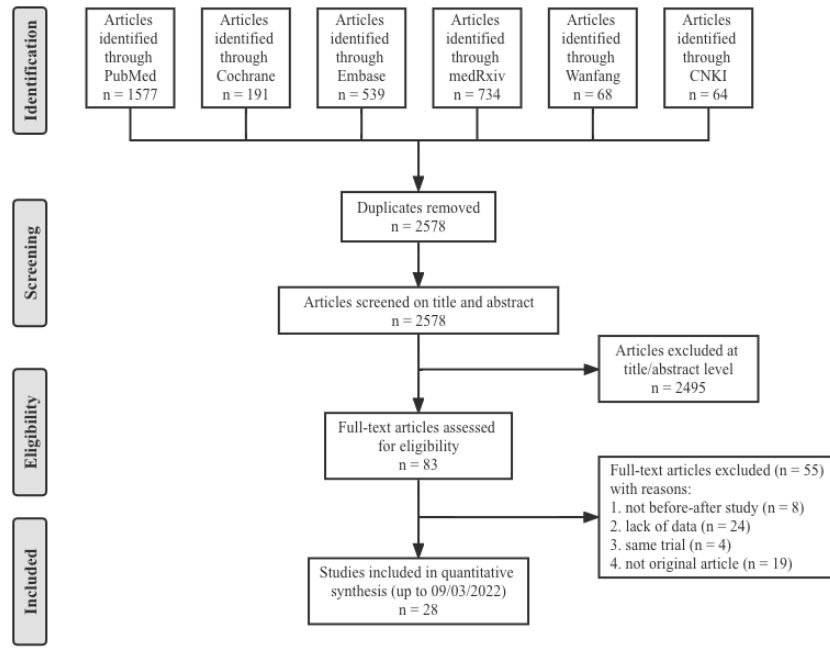
Figure 1. Flow diagram showing the progress through the stages of meta-analysis.